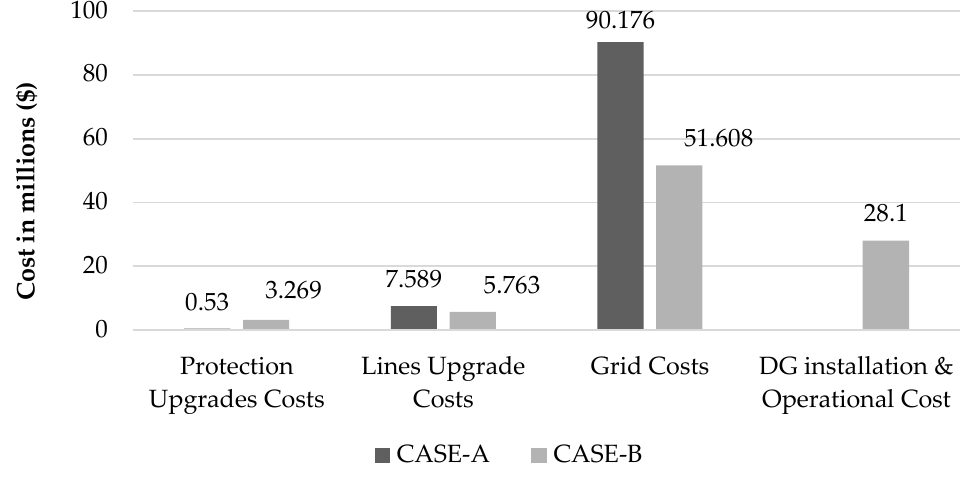
Figure 3. Case-A and Case-B cost breakdown.